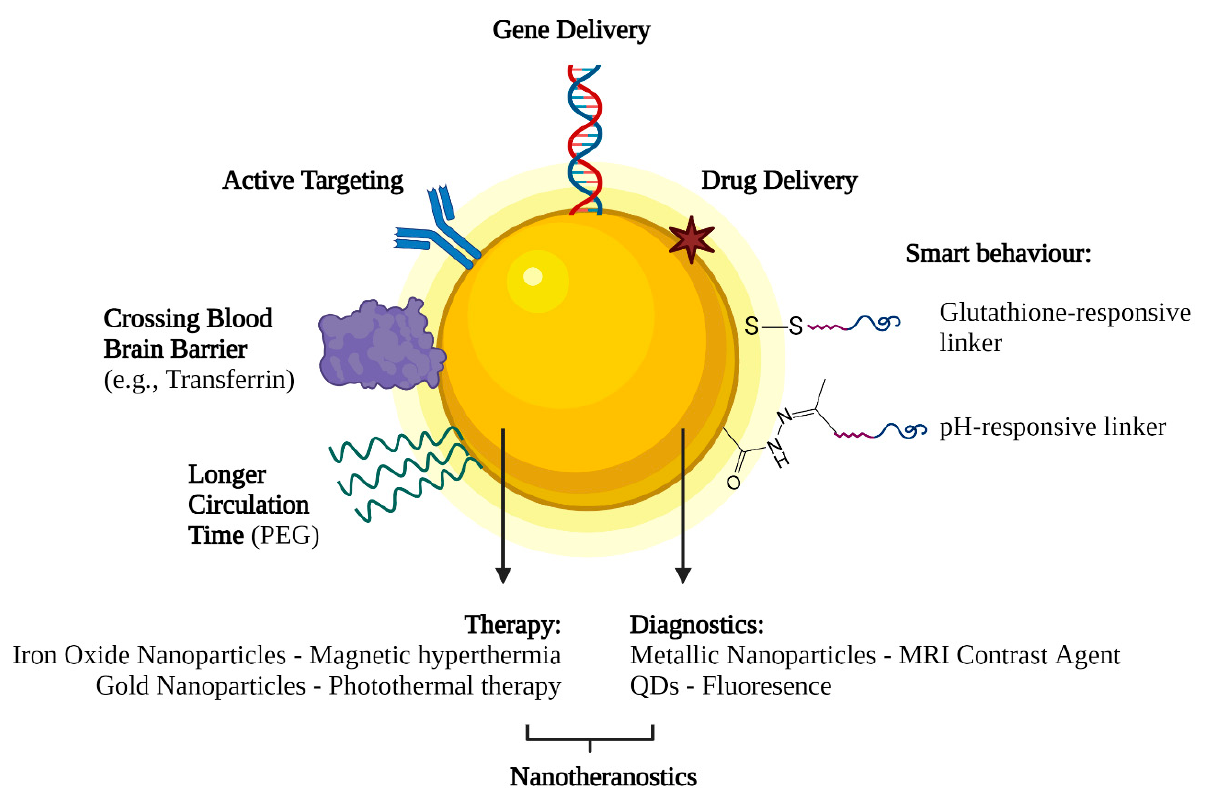
Figure 4. Multifunctionalities of nanotechnology-based delivery systems.